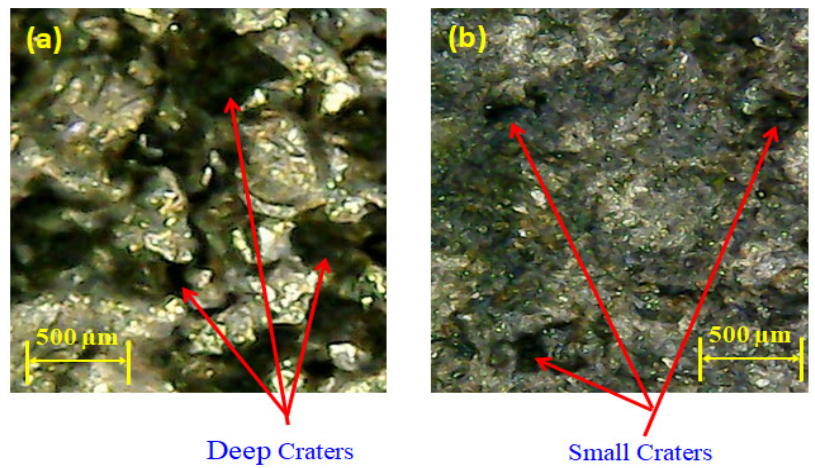
Figure 12. Micrographs showing craters for graphene mixed dielectric: ( a ) deep craters at pulse–time ratio 1.0; ( b ) small craters at pulse–time ratio 1.5.